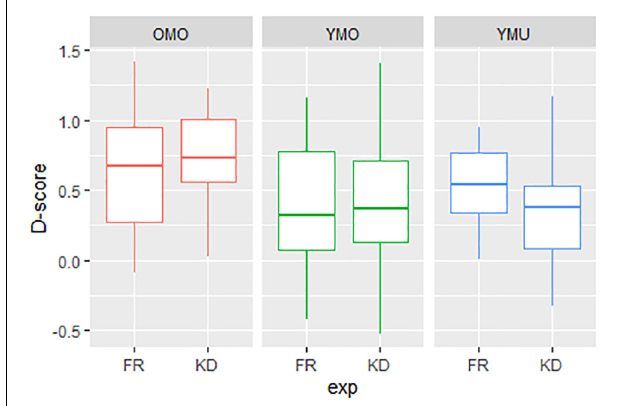
FIGURE 8 | Distributions of D -scores (pronunciation effect, y -axis) as a function of listener group (YMU, YMO, and OMO) and experiment (KB and FR).